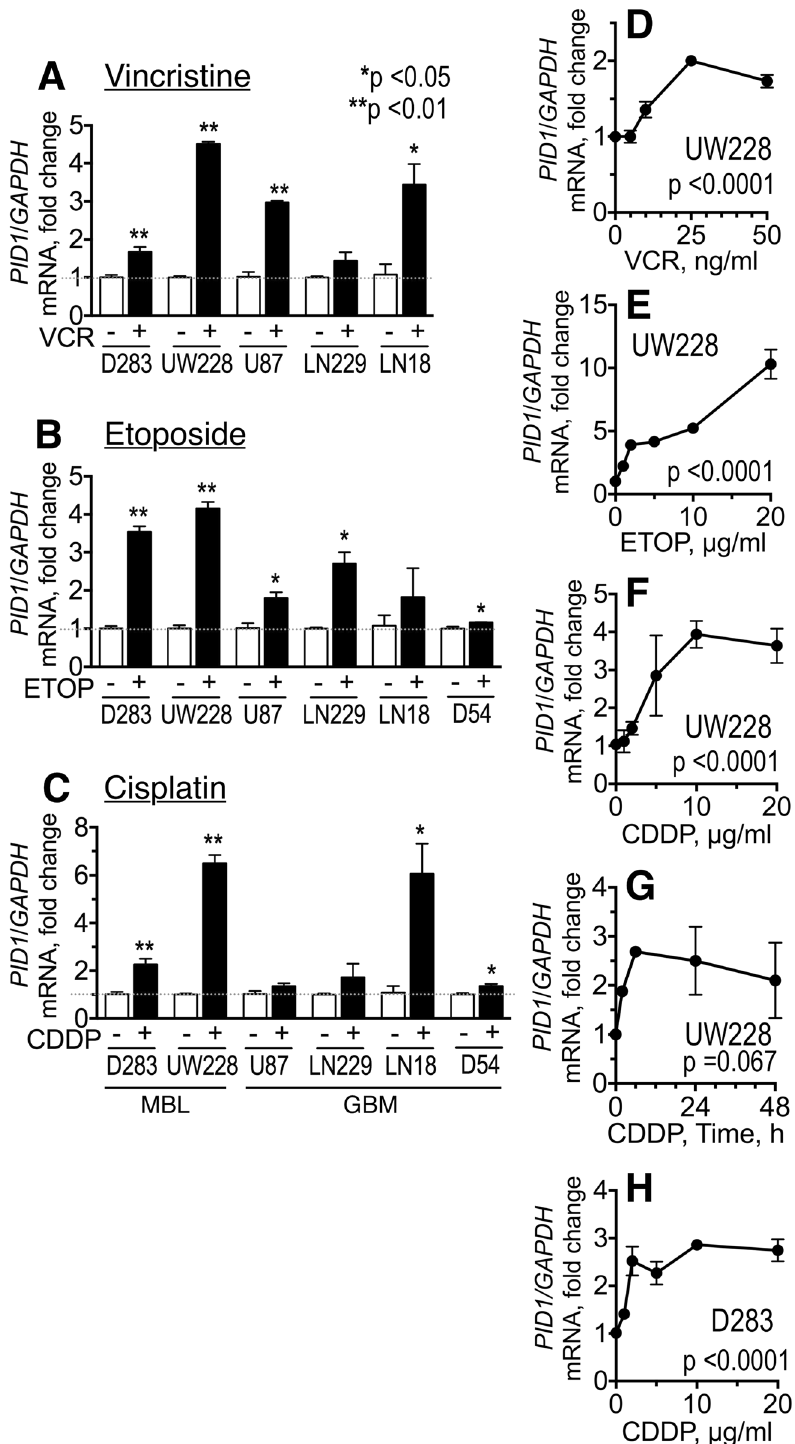
Figure 3. Chemotherapy can increase PID1 mRNA. ( A – C) Medulloblastoma (D283MED, UW228) and glioblastoma (U87, LN229, LN18, D54) cell lines (4 × 10 5 cells/6-well) were treated for 24 hrs with vincristine ( A : 50 ng/ml), etoposide ( B : 5 µ g/ml in D283, UW228, U87, LN229, LN18; 10 µ g/ml in D54), or cisplatin ( C : 5 µ g/ml in D283, U87, LN229, LN18; 10 µ g/ml in UW228-2 and D54). ( D – F) UW228 cells were treated with increasing doses of vincristine (VCR, panel D), etoposide (ETOP, panel E) or cisplatin (CDDP, panel F) for 24 hrs. ( G) UW228 cells were treated with 5 µ g/ml cisplatin for the times indicated. ( H) D283 medulloblastoma treated as in ( F ). In all panels, cells were collected at end of incubation, RNA extracted, and qRT-PCR for PID1 mRNA analyzed. Experiments were performed in triplicate up to three times. Shown are fold change in PID1 mRNA relative to GAPDH mRNA of chemotherapy-treated compared to vehicle-treated cells, normalized to